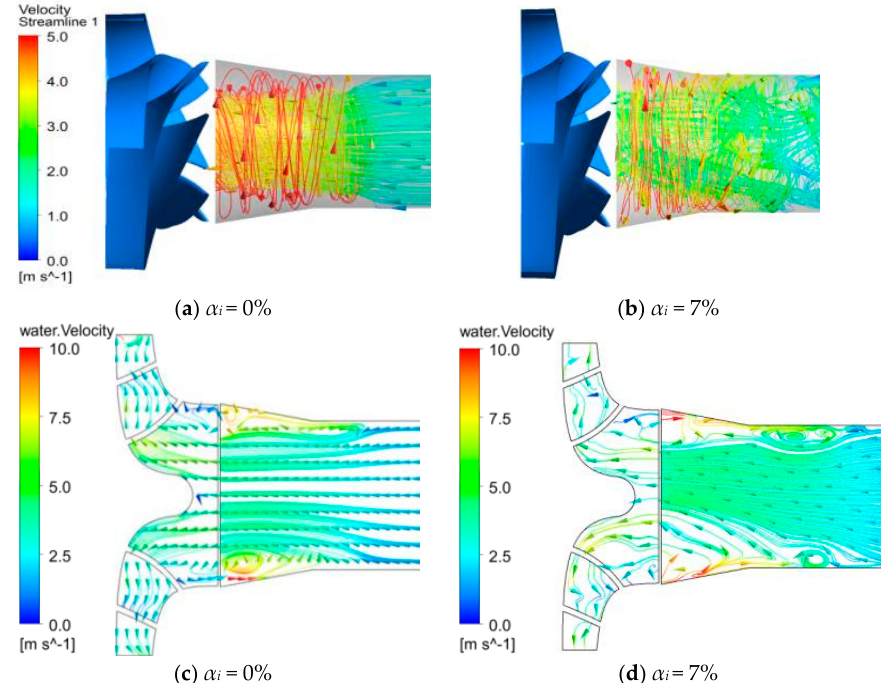
Figure 5. Local two ‐ phase flow streamlines and meridional velocity vectors at impeller inlet and inside the impeller passage (not including impeller wall regions) at nominal rotational speed: 2910 rpm, and low flow coefficient φ = 0.038 (nominal flow coefficient φ n = 0.08) for two different inlet void fractions: ( a ) α i = 0%; ( b ) α i = 7%; ( c ) α i = 0%; ( d ) α i = 7%. Extracted from Si et al. [28].